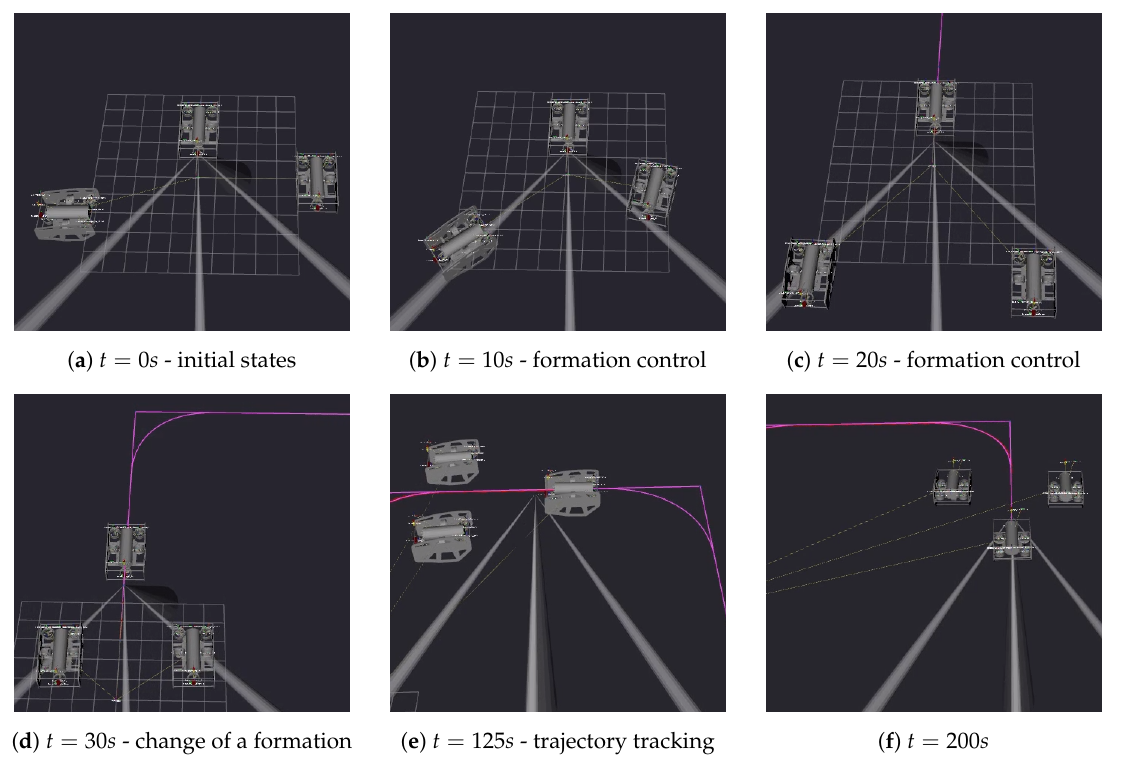
Figure 7. An example of the evolution of three BlueROV-1 in robot operating system